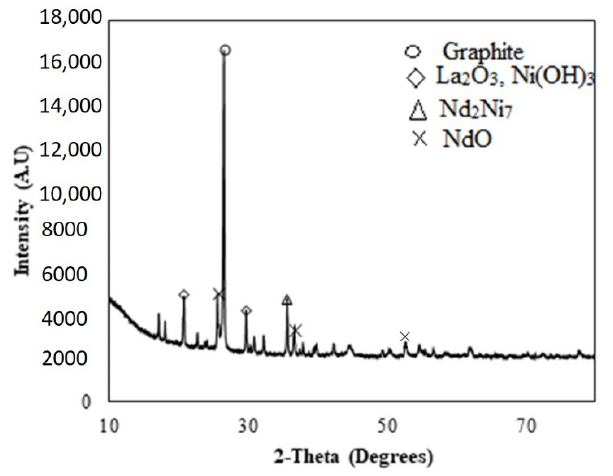
Figure 4. XRD pattern of black powder obtained from NiMH batteries.